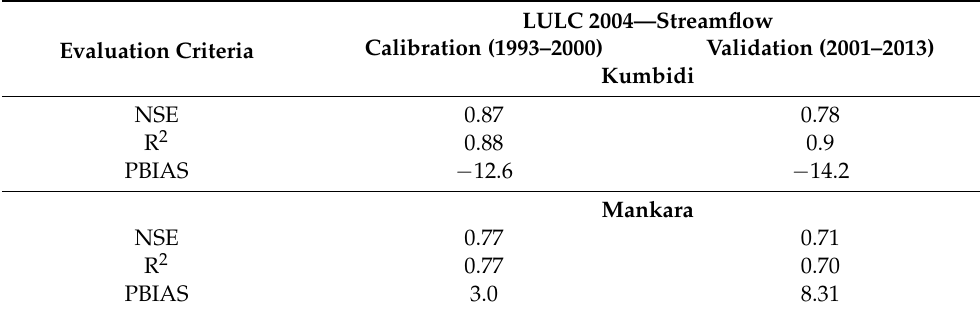
Table 5. Evaluation performance criteria of the model during the calibration and validation period at the Mankara and Kumbidi gauging stations.